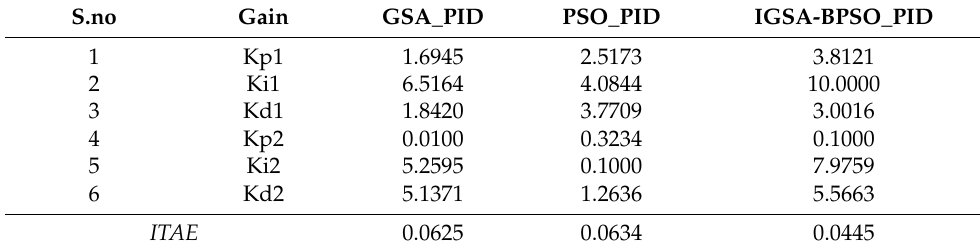
Table 1. PID Parameters tuning for hybrid test system and ITAE values: